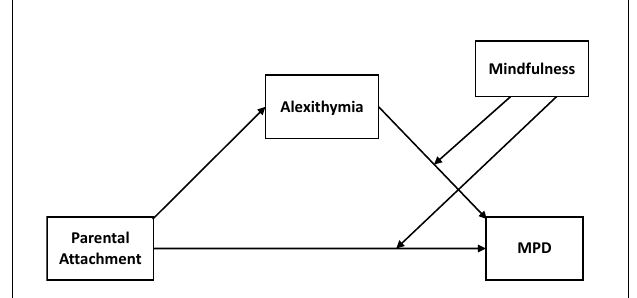
FIGURE 1 | The hypothetical structure model. MPD, mobile phone